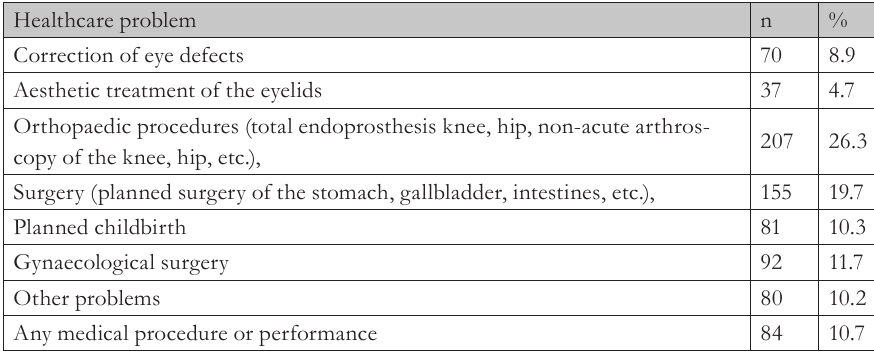
Tab. 3 – The structure of the healthcare problem (Source: own